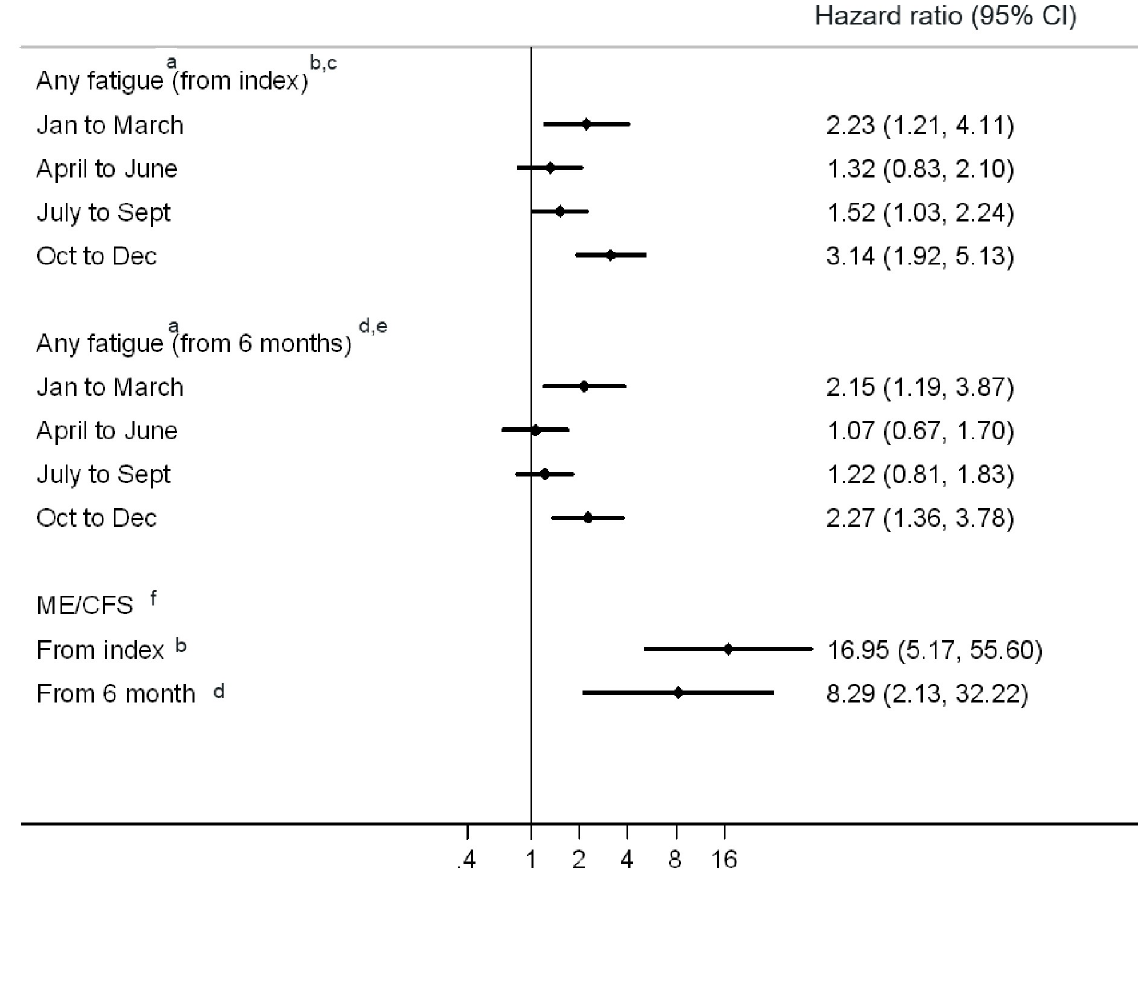
Fig 3. Hazard ratios for incidence of any fatigue and chronic fatigue syndrome in Lyme disease patients versus comparator (non-Lyme disease)